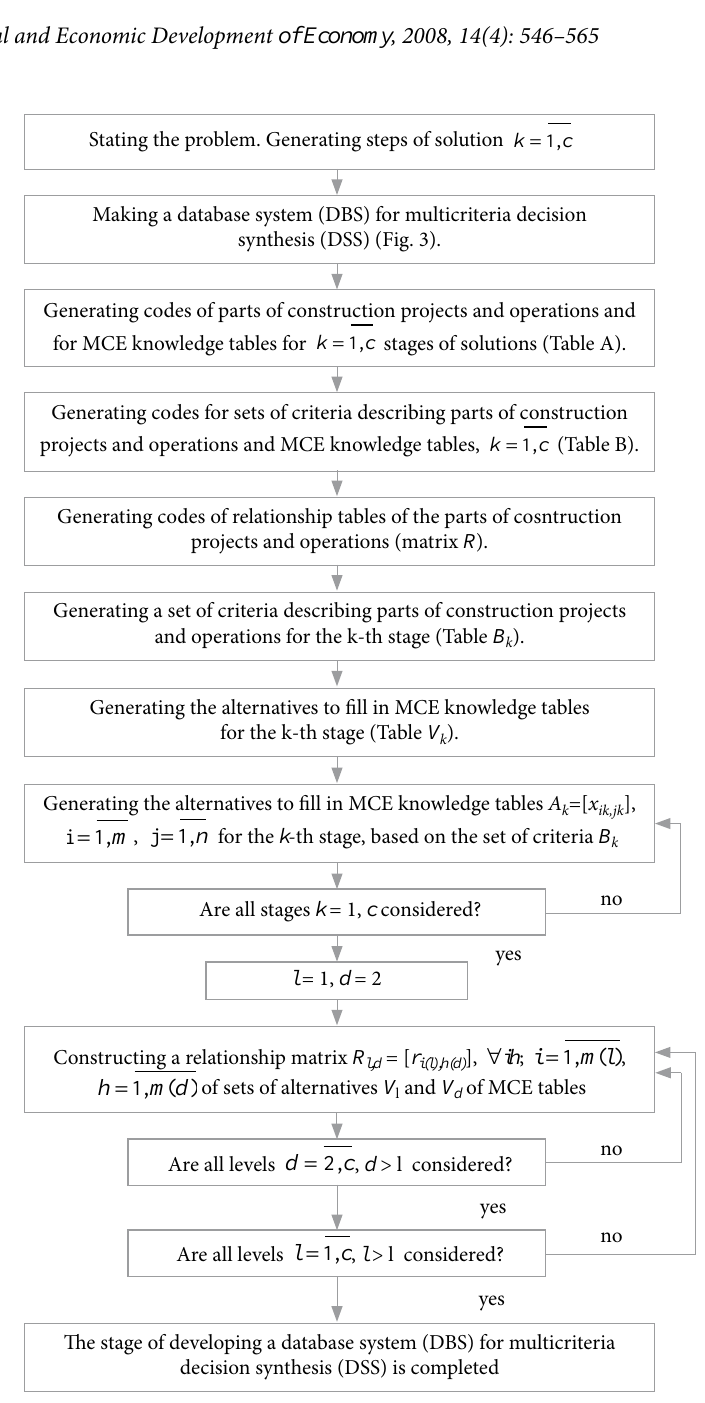
Fig. 3. Block-diagram of database system (DBS) development in DSS1